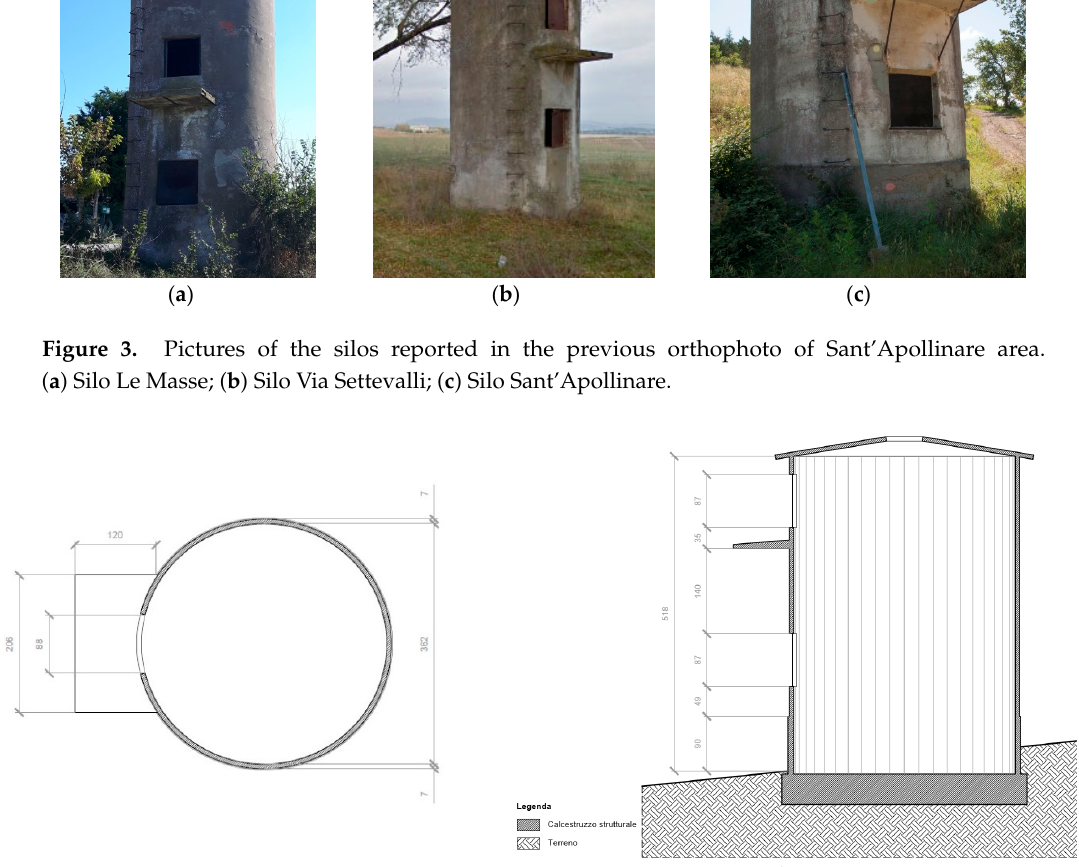
Figure 4. Survey and measurement process of silo’s geometry, base, and profile: ( a ) Plan; ( b ) Section. The dimensions are expressed in meters.